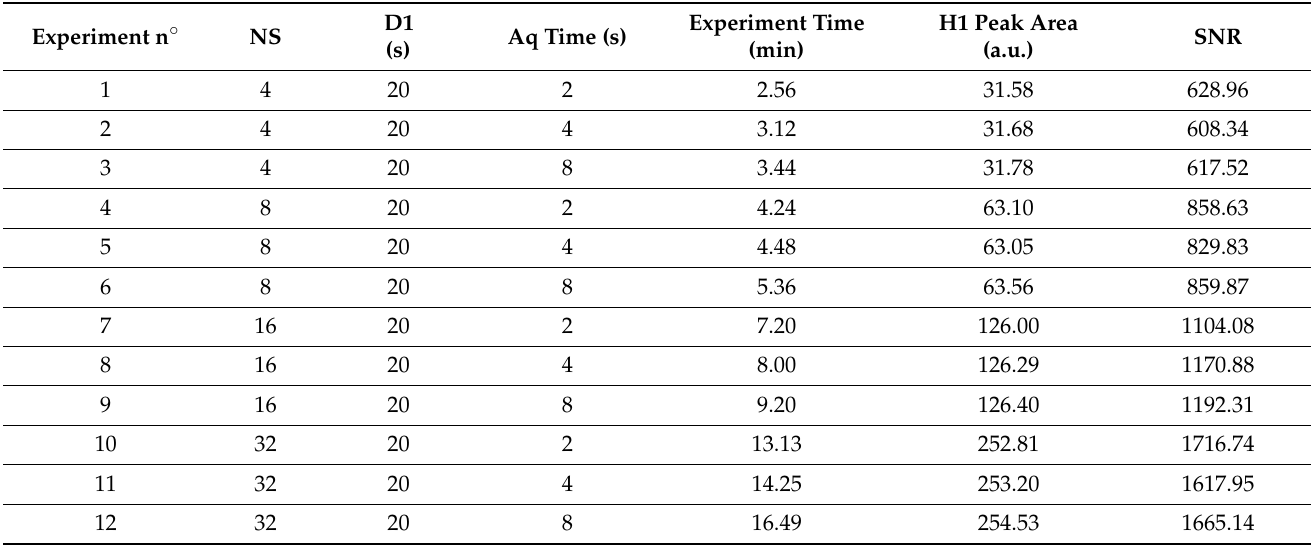
Table 4. Impact of scan number (NS) and acquisition time (Aq time) on AA peak area and signal/noise ratio (SNR) in 1 H-NMR spectra of an ascorbic acid